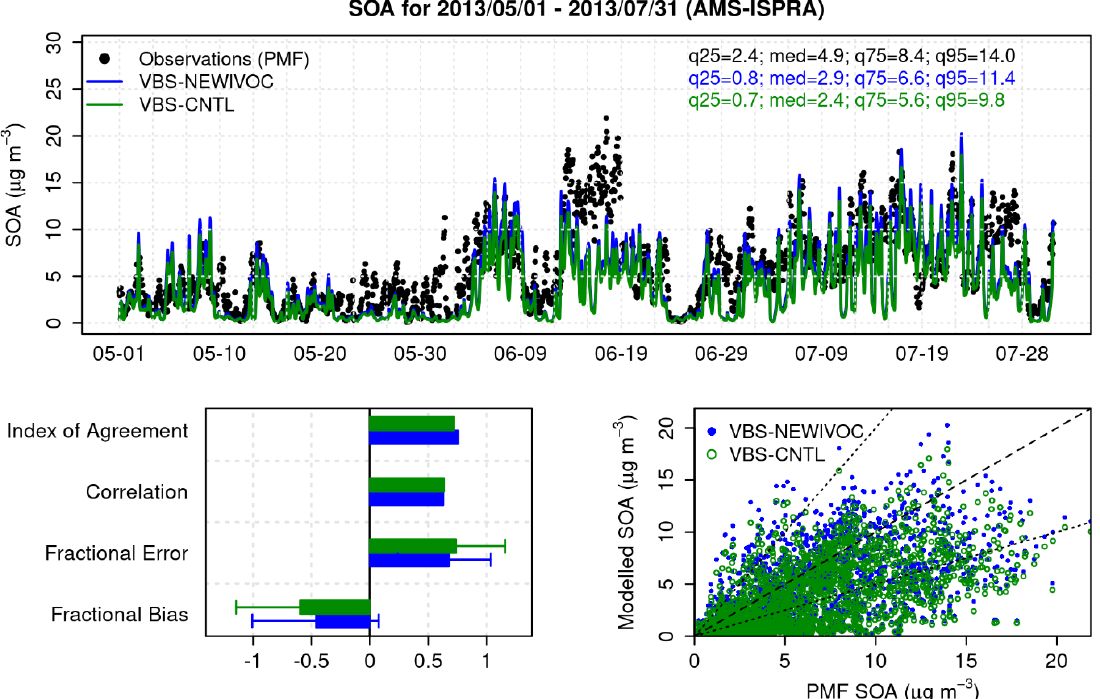
Figure 2. Comparison among modeled and observed (PMF results, black) SOA concentrations in May – July 2013 at the Ispra site: VBS base scheme (VBS-CNTL, green) and VBS scheme with new parameterizations for IVOC emissions (VBS-NEWIVOC, blue).